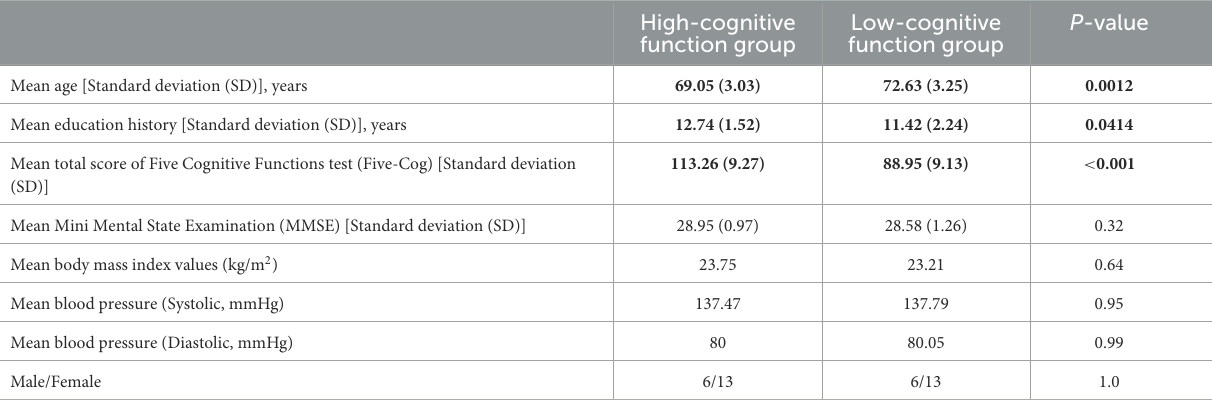
TABLE 2 Descriptive statistics and demographic information.